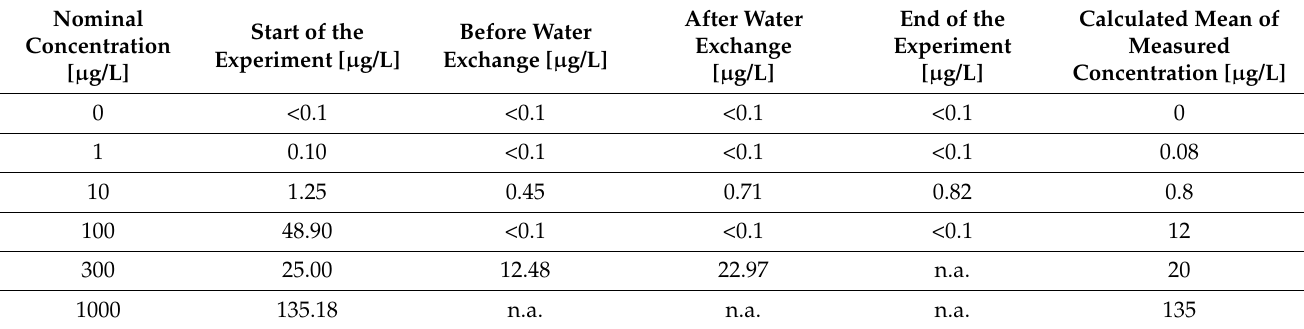
Table 1. Nominal and measured amitriptyline concentrations of the first experiment (limit of quan- tification (LoQ) 0.1 µ g/L; n.a.: not analyzed; for calculation of mean exposure concentrations values below the limit of quantification were substituted with LoQ/